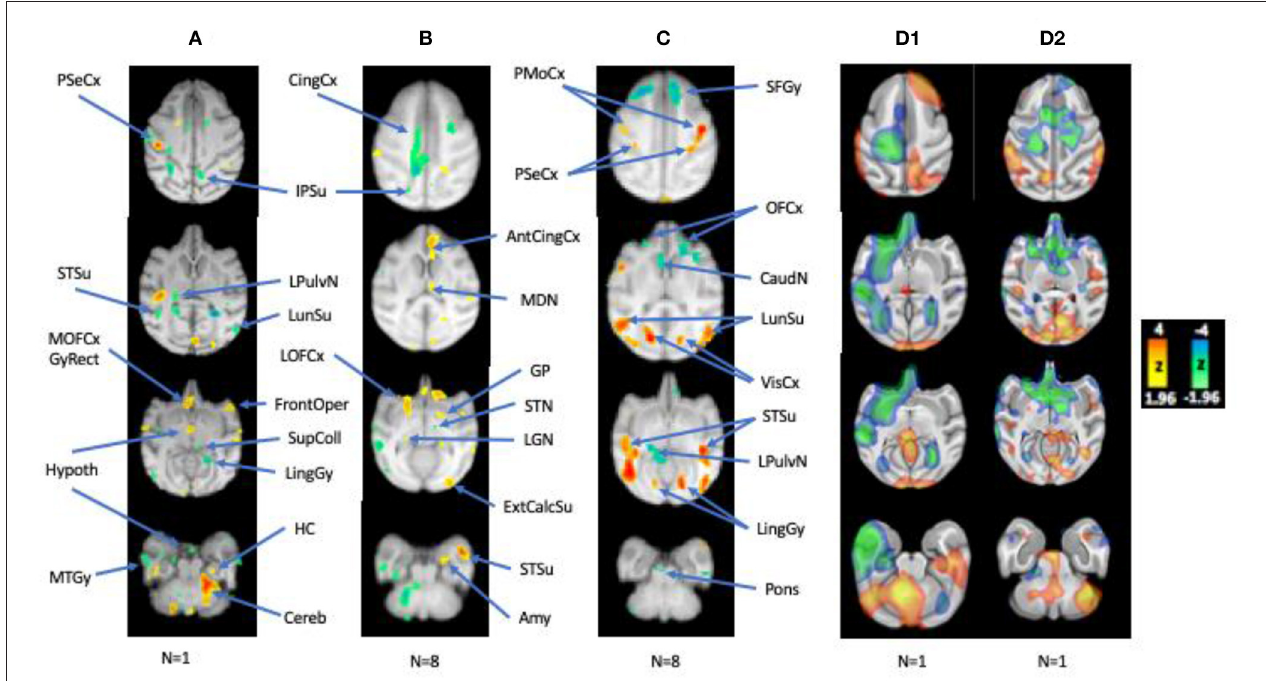
FIGURE 3 | Regional CBF Changes with IPS, Correlated with IEDs, and during HF-VNS therapy. (A,B) Early and late CBF changes with IPS, (C) CBF changes correlated with interictal epileptic discharges, (D1,D2) CBF changes in a photosensitive baboon and a non-photosensitive animal related to HF microburst VNS Therapy at rest (compared to the resting-state average from nine epileptic baboons). L hemisphere is on the left. Adapted from references ( 46, 52,